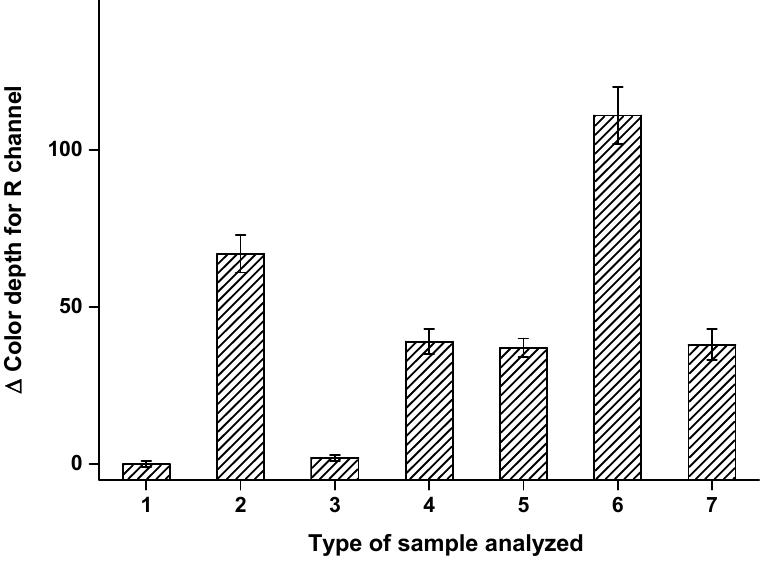
Figure 10. The effect of tetraisopropyl pyrophosphoramide (iso-OMPA) on the smartphone camera- based colorimetric assay and the measuring pad modified with indoxylacetate assay of acetyl- cholinesterase (AChE), butyrylcholinesterase (BChE) and a mixture of AChE and BChE. Type of sample analyzed: ( 1 ) application of saline solution to the well with indoxylacetate and iso-OMPA; ( 2 ) 40 µ L AChE 50 µ kat/mL; ( 3 ) 40 µ L AChE 50 µ kat/mL and 0.1 mmol/mL iso-OMPA; ( 4 ) 40 µ L BChE 50 µ kat/mL; ( 5 ) 40 µ L BChE 50 µ kat/mL and 0.1 mmol/mL iso-OMPA; ( 6 ) 40 µ L 50 µ kat/mL BChE and 50 µ kat/mL BChE; ( 7 ) 40 µ L 50 µ kat/mL AChE, 50 µ kat/mL BChE and 0.1 mmol/L iso-OMPA. Standard error of the mean is expressed for five independent repeats. R red.